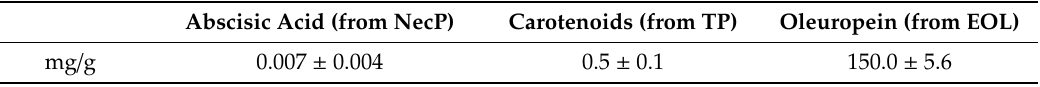
Table 2. HPLD-DAD determination of the main bioactive components in the nutraceutical products. Abscisic Acid (from NecP) Carotenoids (from TP) Oleuropein (from EOL) mg / g 0.007 ± 0.004 0.5 ± 0.1 150.0 ±